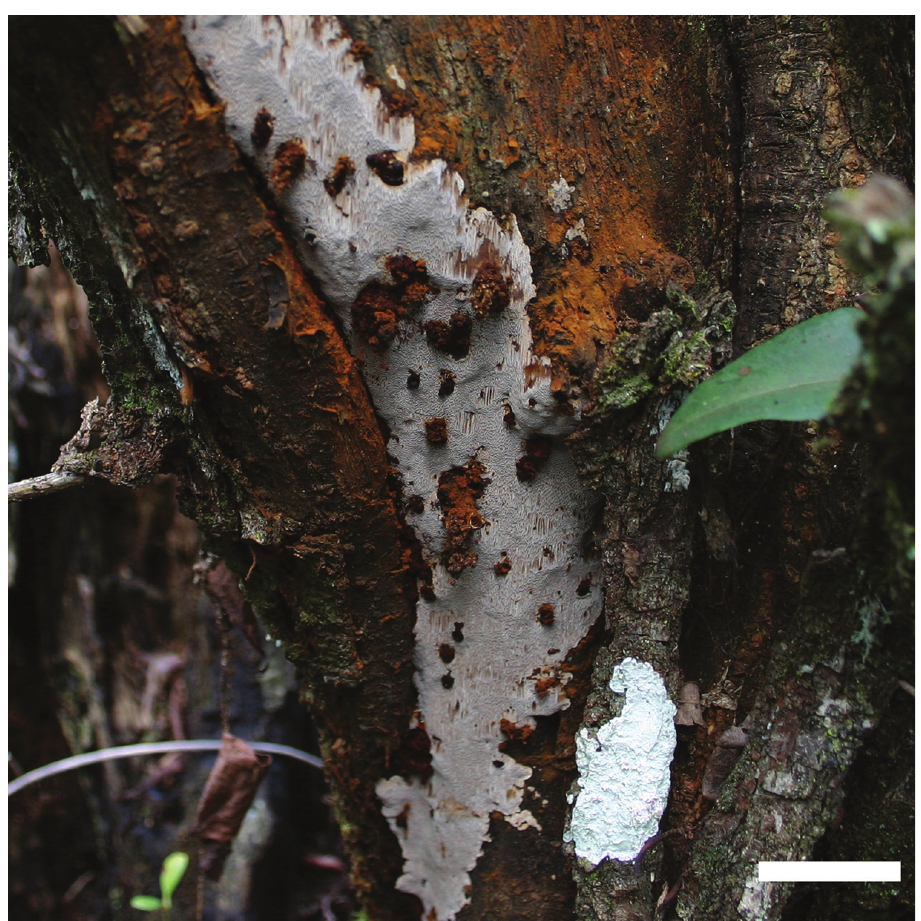
Figure 5. Basidiomata of Fomitiporella mangrovei . Scale bar: 5 cm.